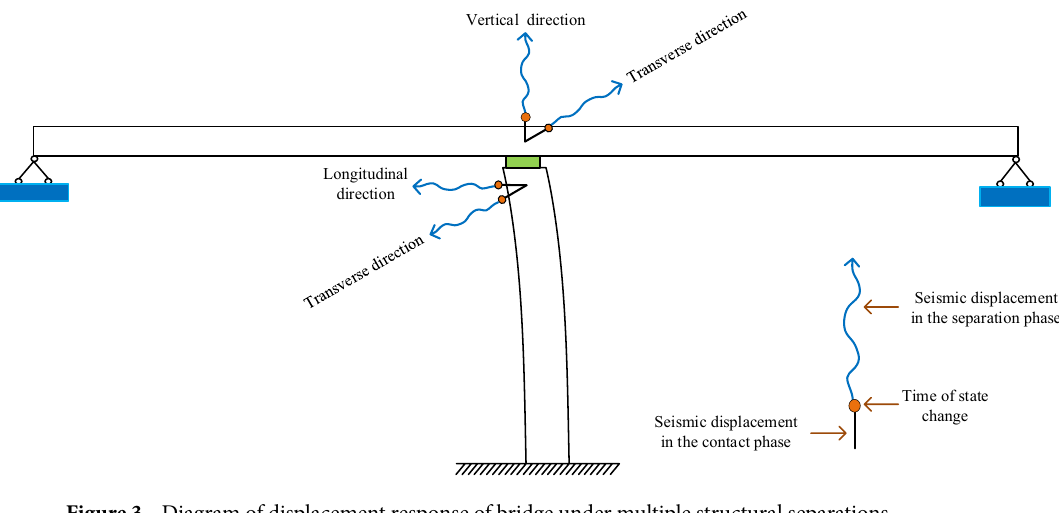
Figure 3. Diagram of displacement response of bridge under multiple structural